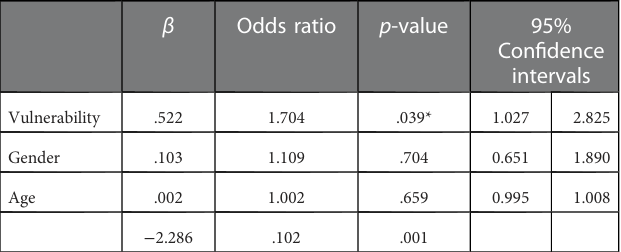
TABLE 2 Results of the effects of vulnerability on depressive symptoms.